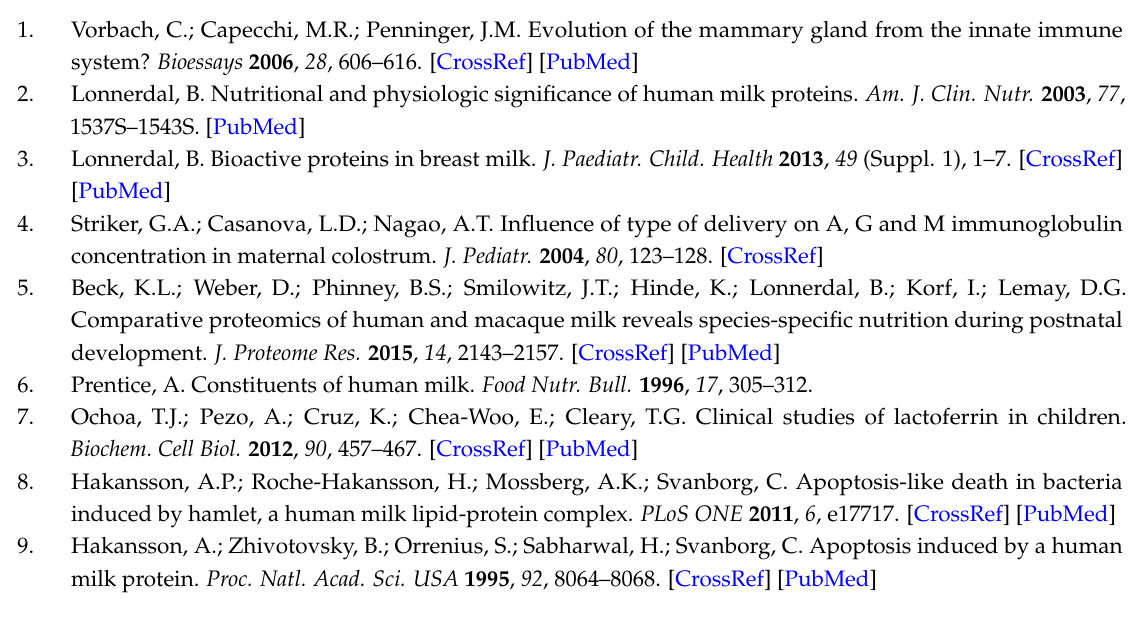
Figure S1: Comparison of major milk protein content for (A) α -lactalbumin; (B) lactoferrin; (C) serum albumin and (D) total casein for each lactation period. Box plot represent medians ( n = 90 per lactation period) with 25th and 75th percentile, min-max range and outliers. Statistical significance was set at p < 0.05 and significant p -values are indicated in the